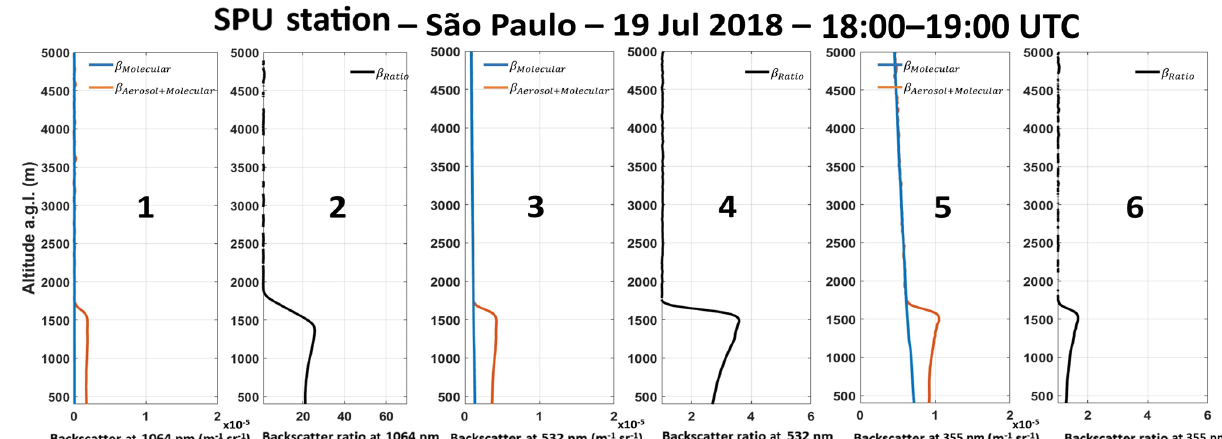
Figure 13. Total (aerosol and molecular) backscatter profile and backscatter ratio retrieved using Klett–Fernald–Sasano inversion technique for 1064, 532 and 355nm, respectively, for data retrieved on 19 July 2018 from 18:00 to